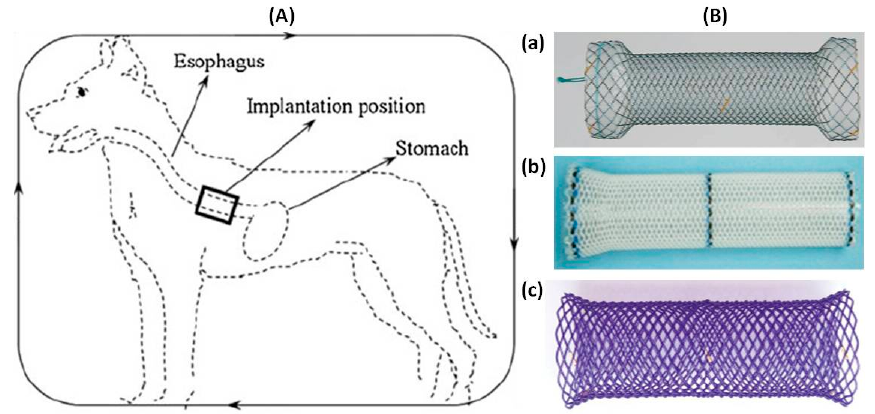
Figure 1. Stent insertion ( A ) [4] and stents ( B ) currently used for benign or malignant esophageal strictures: ( a ) Niti-S covered stent (Taewoong Medical); ( b ) Polyflex stent (Boston Scientific); and ( c ) ELLA-BD stent (ELLA-CS). Copyright permission from Springer.